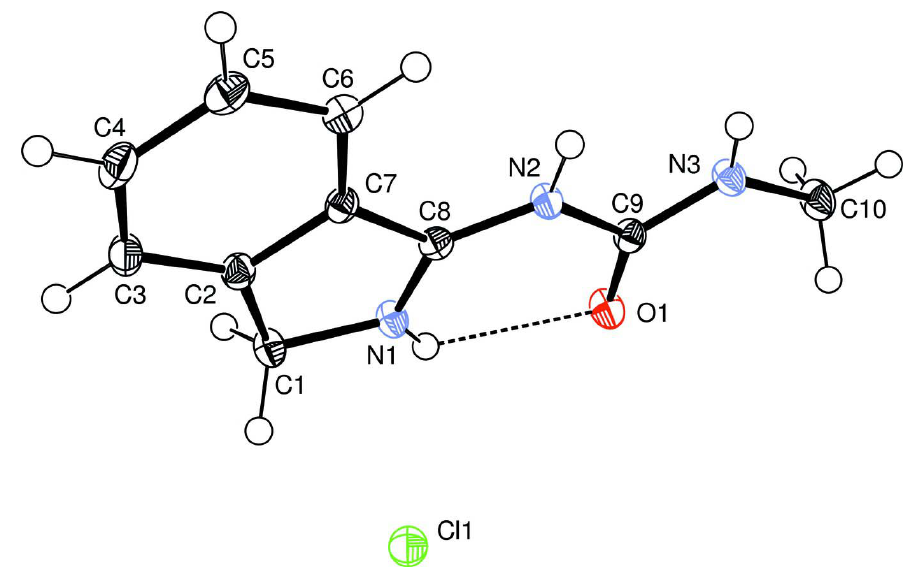
Figure 1 The title compound (I) with displacement ellipsoids drawn at 50% probability level. Intramolecular H-bonds are indicated by broken lines.